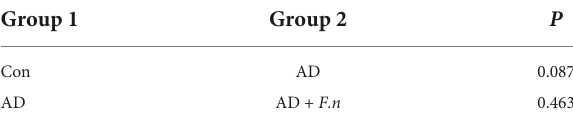
TABLE 1 Comparison of the overall microbial community structure using